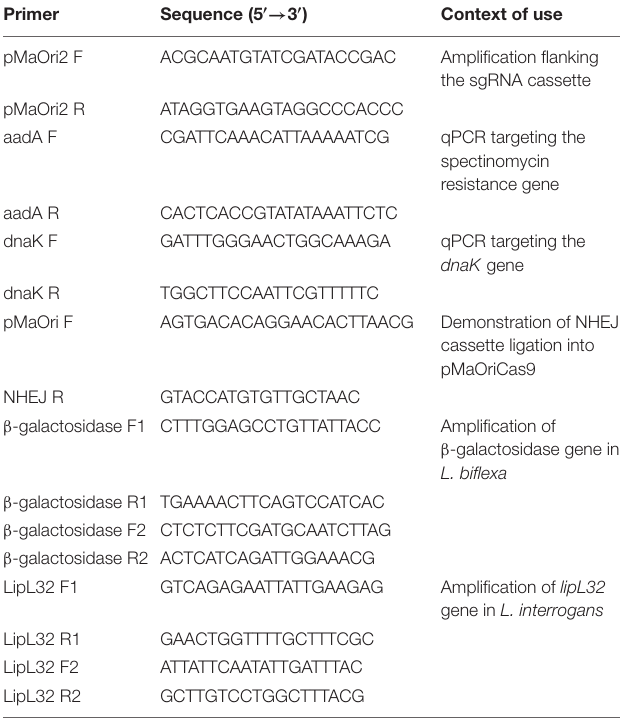
TABLE 1 | Primer sequences used in this